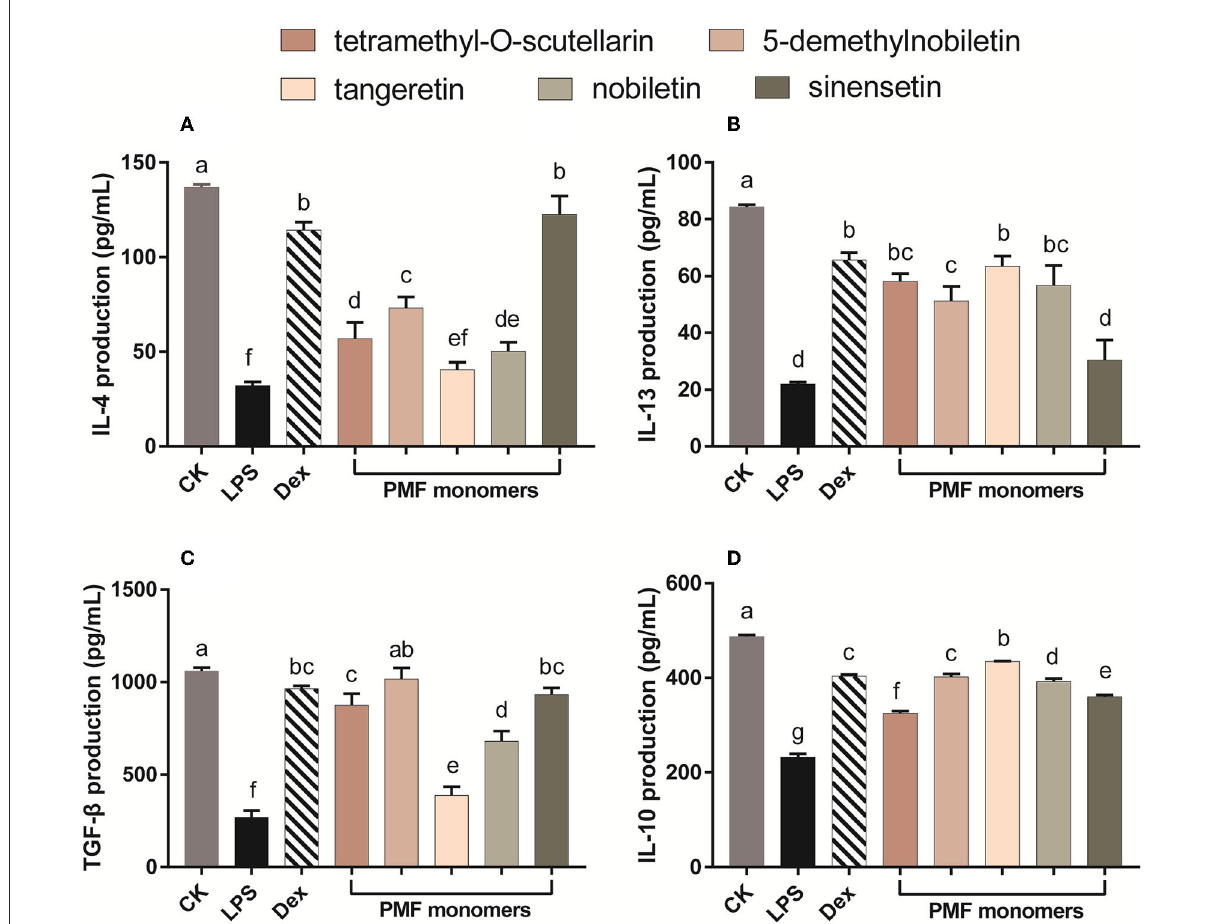
FIGURE4 Effect of different PMFs on anti-inflammatory cytokines in the LPS-stimulated RAW264.7 macrophage cells. (A) IL-4; (B) IL-13; (C) TGF-â; (D) IL-10. Results were expressed as means ± SD, n = 3 experiments. Means denoted by different lower-case letters are significantly different (One-way ANOVA, Dunnett’s post-hoc test, p <